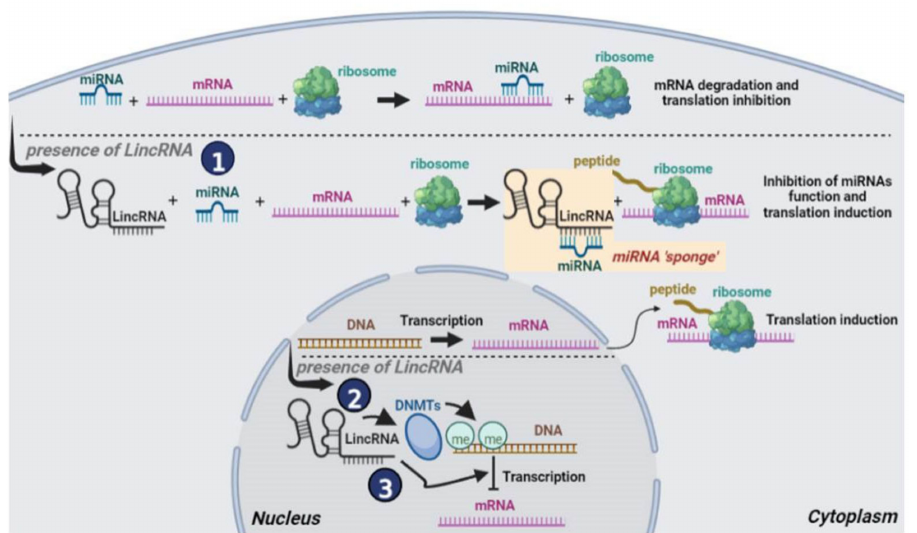
Figure 2. Schematic representation of the function of lincRNAs in breast cancer cells: (1) In the cytoplasm, lincRNAs sponge specific miRNAs repressing their functions and thus repressing specific mRNA translation. The sponging process is shown inside the yellow box. (2) In the nucleus, lincRNAs attract DNMTs to specific gene promoters whose methylation represses gene expression, and (3) In the nucleus lincRNAs inhibit the expression of tumor suppressor